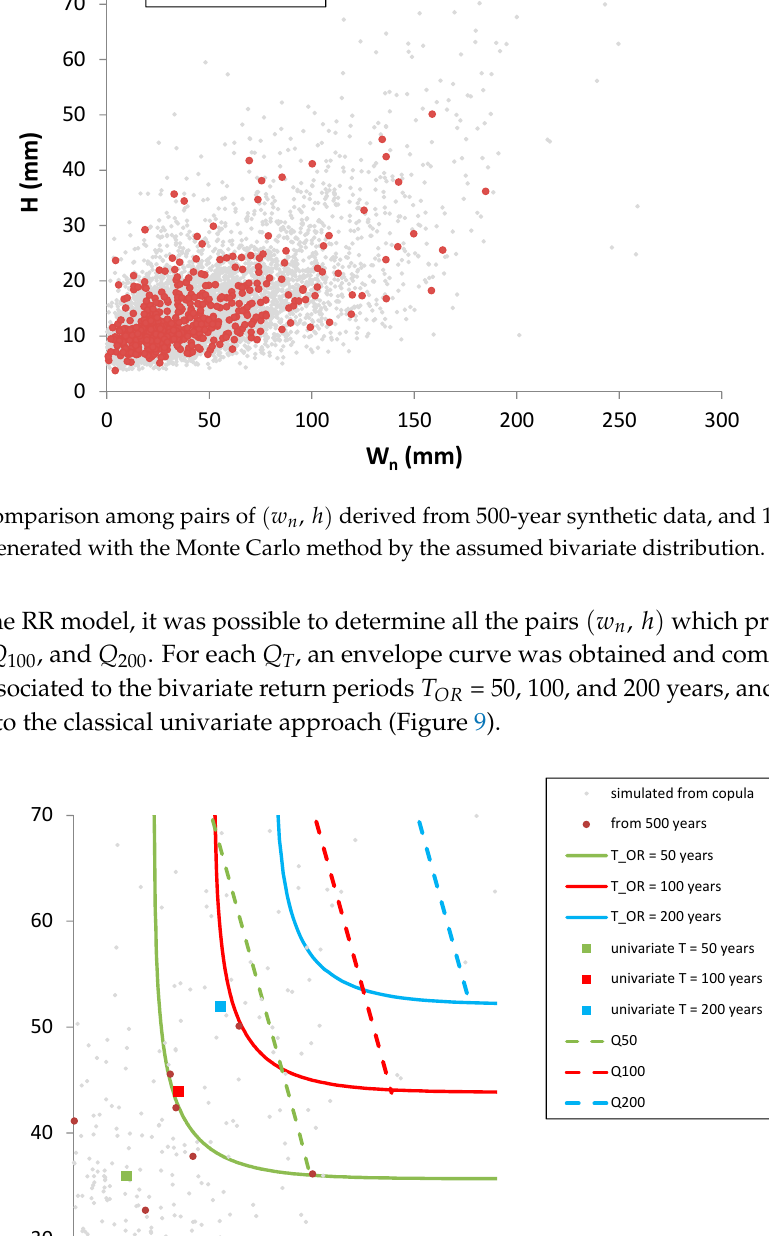
Figure 9 . Comparison between univariate (square boxes) and bivariate analysis (solid lines) for the definition of the design hyetograph. The dotted lines correspond to all the pairs ( w n , h ) providing quantiles Q 50 , Q 100 , and Q 200 of discharge when fed into the adopted rainfall-runoff (RR) model. From the analysis of the obtained results, it is evident that with the hypothesis of Crit d equal to the time of concentration of the basin and with the adopted shape for the hyetograph: